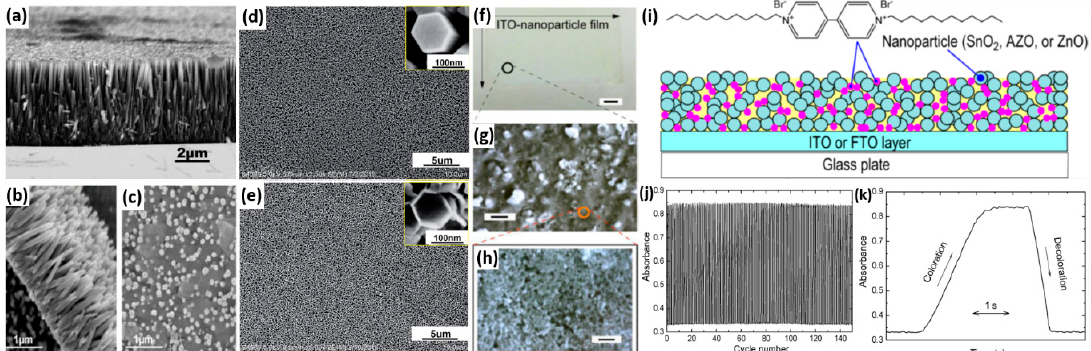
Figure 13. ( a ) SEM image of the ZnO nanowires array hydrothermally grown on ITO glass substrate. SEM image of ( b ) ZnO nanorods grown on ITO / polyethylene terephthalate substrate and ( c ) the ZnO nanorods modified with methyl viologen molecules. SEM images of ( d ) ZnO nanorods and ( e ) ZnO nanotubes hydrothermally grown on ITO glass substrates. ( f ) Photograph and ( g , h ) SEM images of a viologen / ITO nanoparticle electrode. Scale bars in the images are 1 mm, 10 µ m, and 1 µ m, respectively. ( i ) Schematic illustration of metal oxide nanoparticles / viologen composite film electrodes. ( j ) Coloration − decoloration cycles of the SnO 2 -DDV / FTO electrode in aqueous electrolyte between − 0.55 and 0 V at a switching interval of 3 s monitored at a wavelength of 510 nm and ( k ) the extracted short-term cycles with absorbance plotted as a function of time. Readapted with permission from American Chemical Society [98,103], Elsevier B.V. [99,102] and The Royal Society of Chemistry